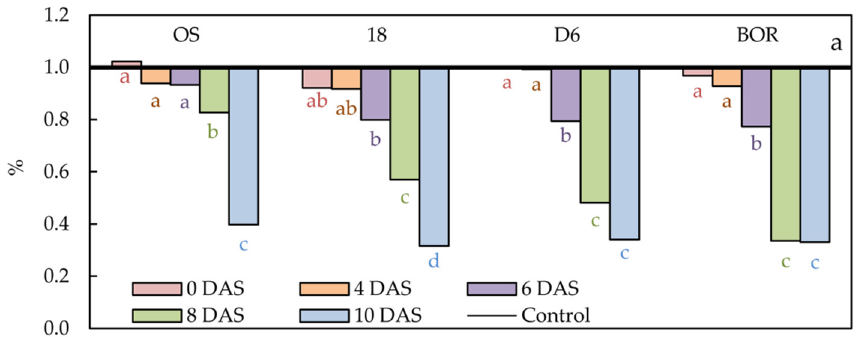
Figure 1. Relative water content (RWC) in the leaves of Obla č inska sour cherry ecotypes (OS, 18, D6, and BOR) under control and drought conditions was obtained at 0, 4, 6, 8, and 10 days after stress (DAS). Normalized values of drought treatments according to control treatments are presented as mean values ( n = 5). Points labelled with different letters differ significantly at p < 0.05. Raw data are presented in Table S1.